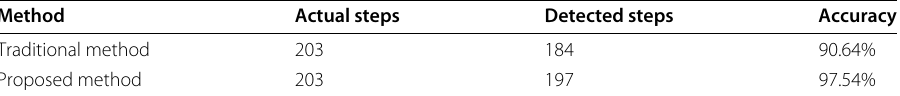
Table 2 Comparison of different algorithms Method Actual steps Detected steps Accuracy Traditional method 203 184 90.64% Proposed method 203